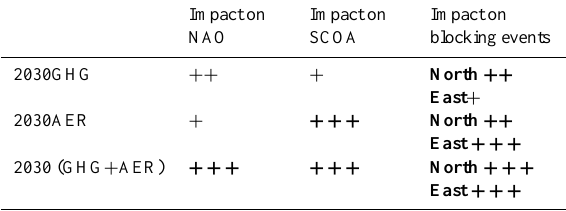
Table 4. Qualitative contributions (small ( + ) , medium ( ++ ) , high ( +++ )) of 2030GHG and 2030AER to changes in the NAO phase, SCOA location and blocking event frequency. For the blocking events, the direction of the increased frequency is also shown. The contributions significant at 95% confidence level are shown in